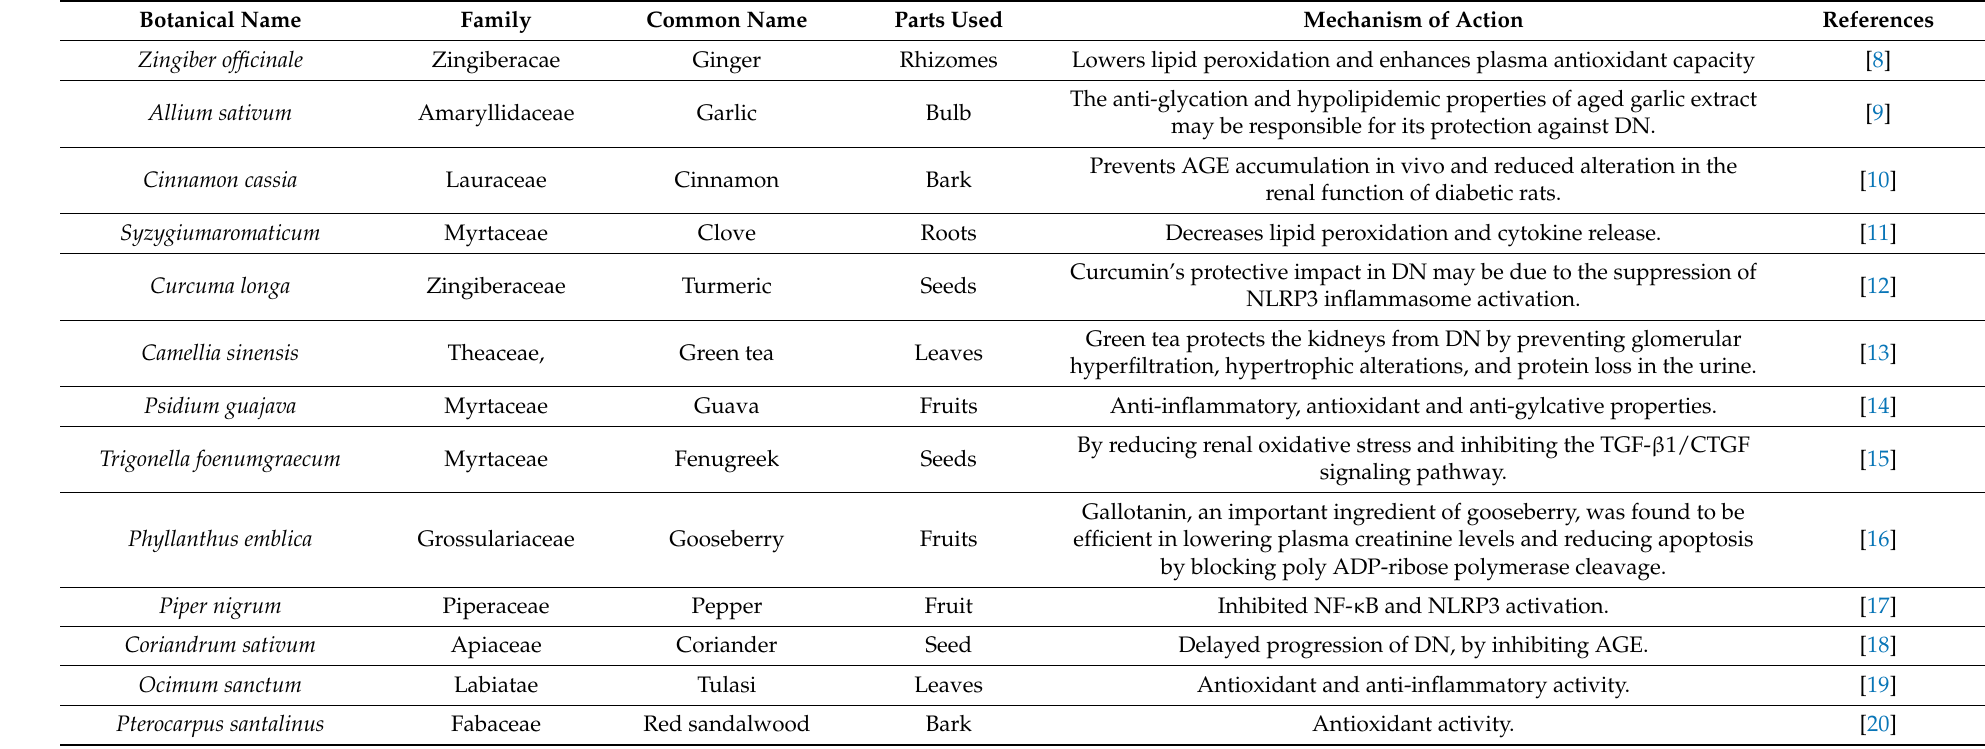
Table 1. List of medicinal plants and their action on diabetic